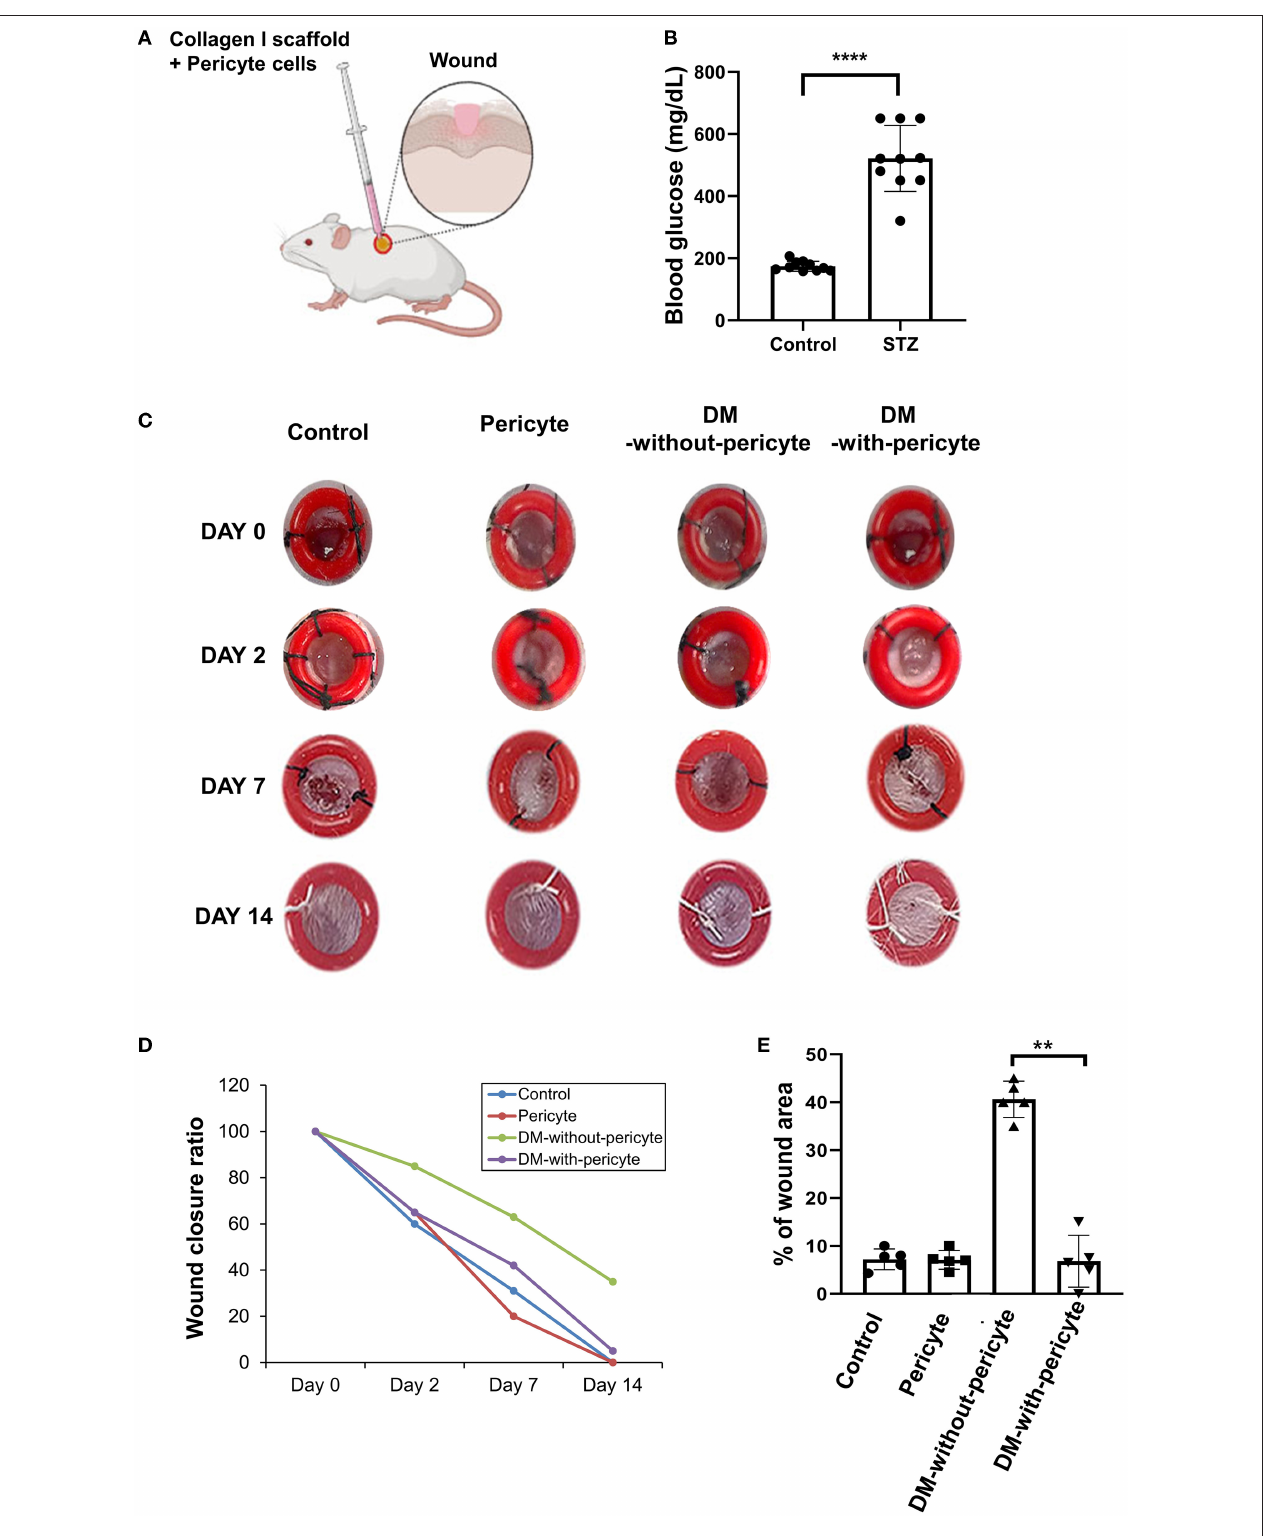
FIGURE 3 | The diabetes mellitus (DM)-with-pericyte group exhibited substantial wound healing in a mouse wound model. (A) Illustration of injection of collagen type 1 scaffold + 5 × 10 5 pericytesinthemousewound. (B) Streptozotocin(STZ)-induceddiabeticmiceonbloodglucoseconfirmedsuccessfulDMinduction(**** P <